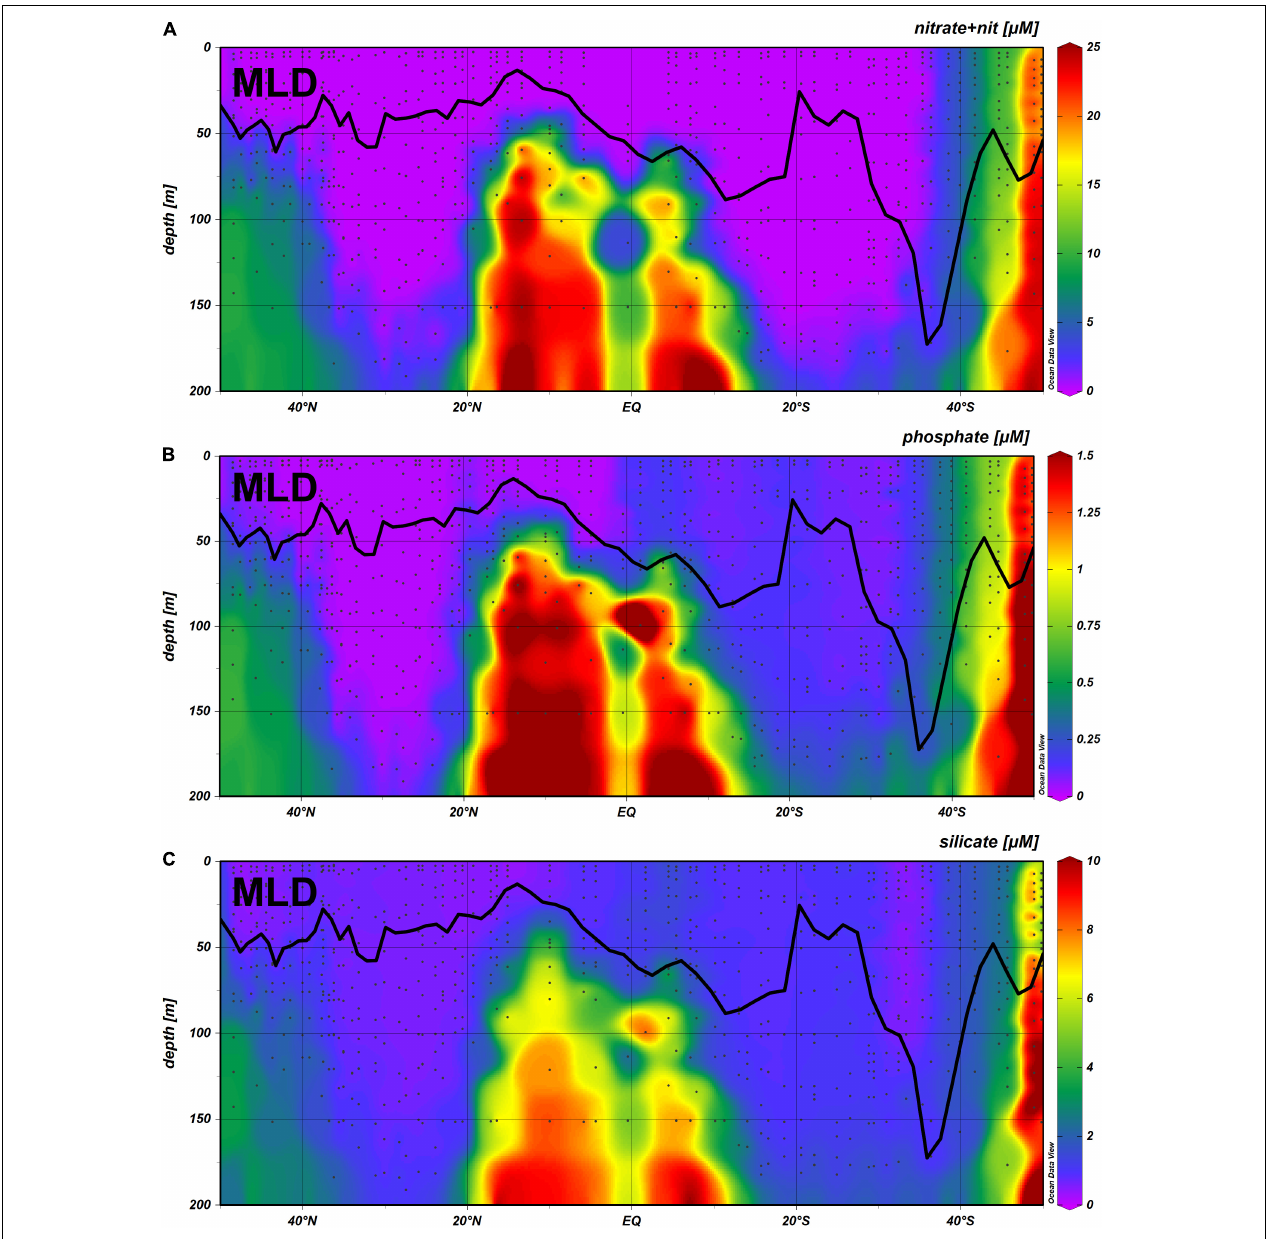
FIGURE 2 | Concentration of nitrate + nitrite (A) , phosphate (B) and silicate (C) , from surface to 500 m depth, along the AMT25 transect, with the Mixed Layer Depth plotted along the transect.